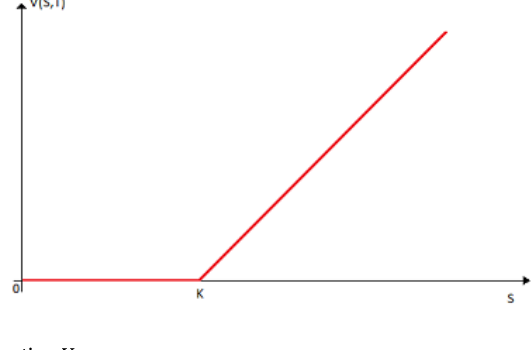
Fig. 2: The terminal value of the option V